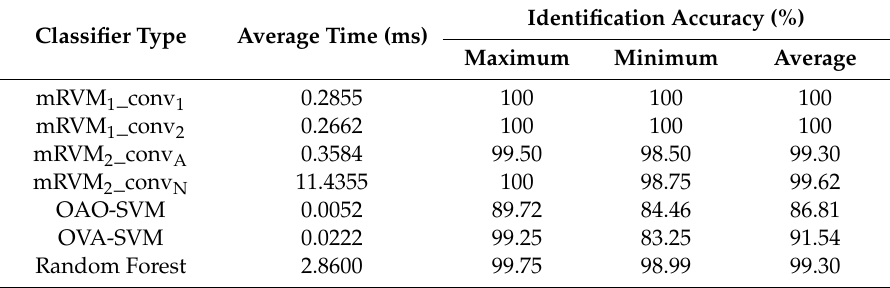
Table 10. The fault identification accuracy of di ff erent classifiers with the load 3